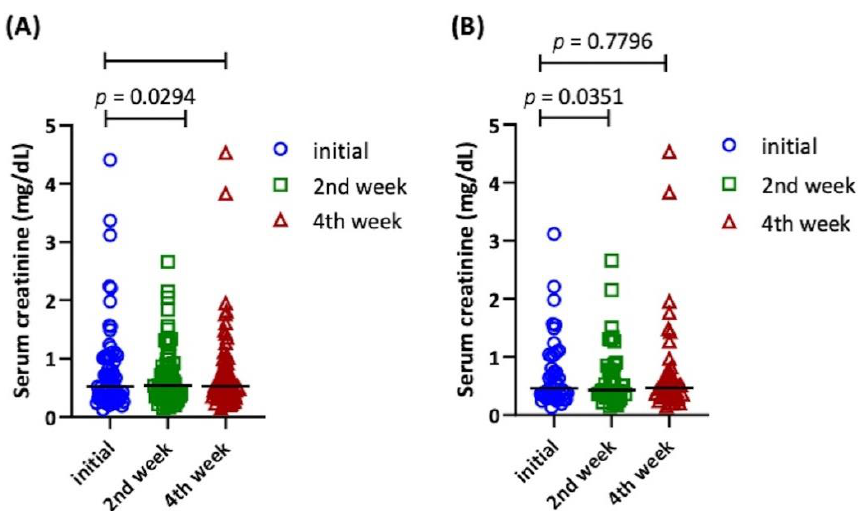
Figure 5. Comparison of baseline, 2nd week, and 4th week serum creatinine levels with different daily protein intakes. ( A ) Daily protein intake ≥ 1.065 g/kg/day; ( B ) daily protein intake ≥ 1.2 g/kg/day.